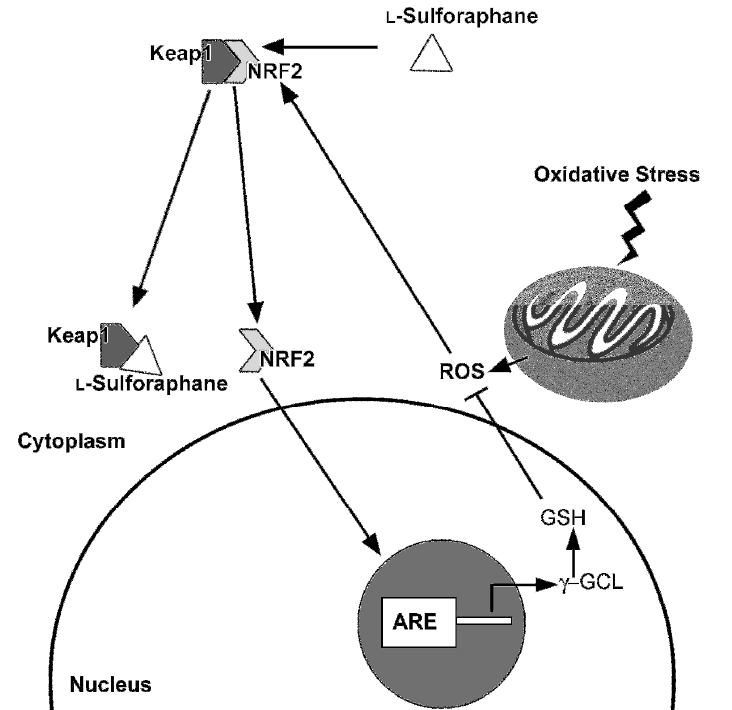
Figure 4. Activation of the Nrf2 transcription factor pathway by L -sulforaphane. The schematic shows a general mechanism by which ARE-mediated gene transcription is